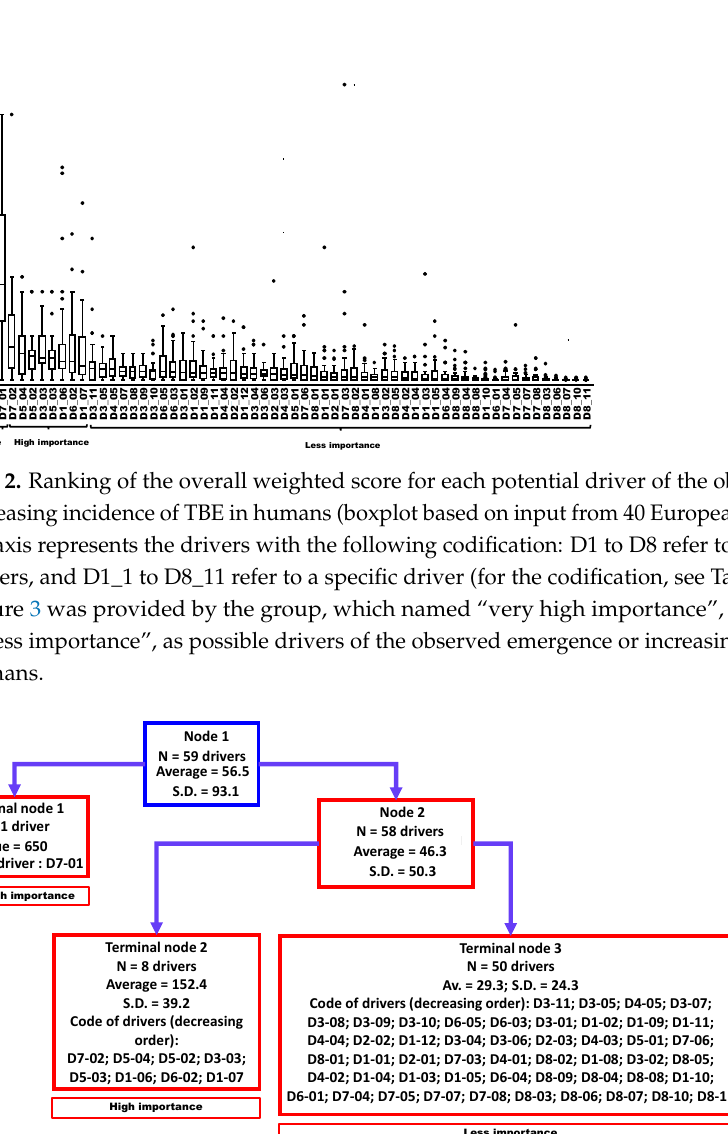
the median of domain D1 as a reference (median regression; p -value = 0.019). The median